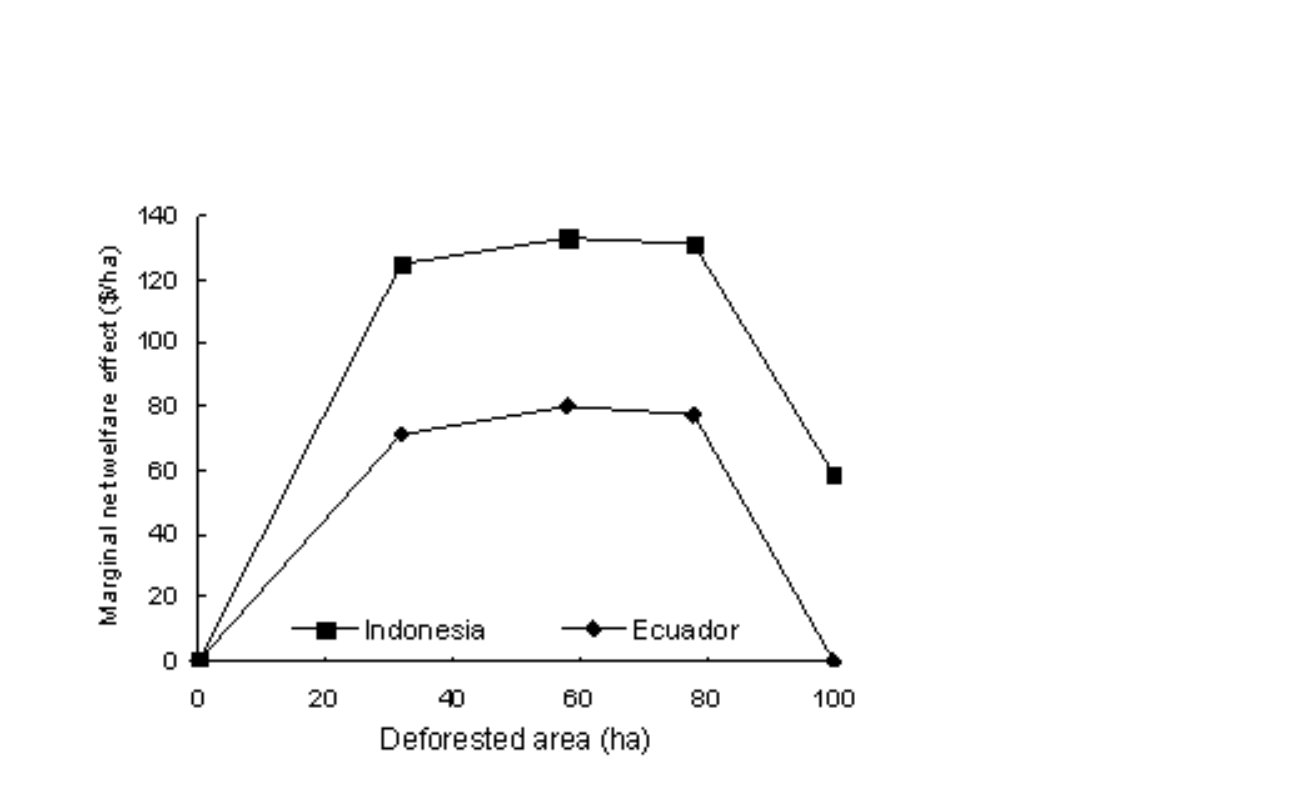
Fig. 4. Marginal net welfare effect per hectare of deforested land. We assumed that 100 ha of forest were converted stepwise (32, 26, 20, and 22 ha) into maize (see also Fig. 3B and Table 2). The marginal net welfare effect combines additional net revenues from maize production and reduced coffee revenues caused by diminished pollination services. Monetary values are in